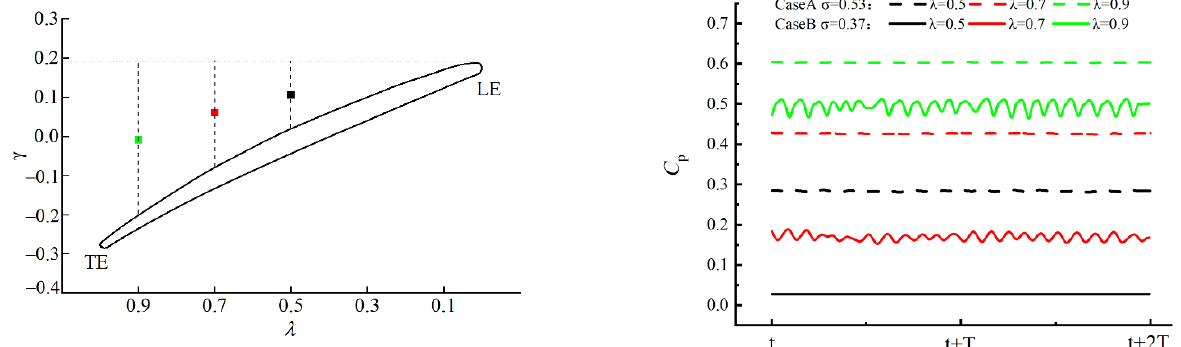
Figure 20. Monitoring points and curves of pressure pulsation.